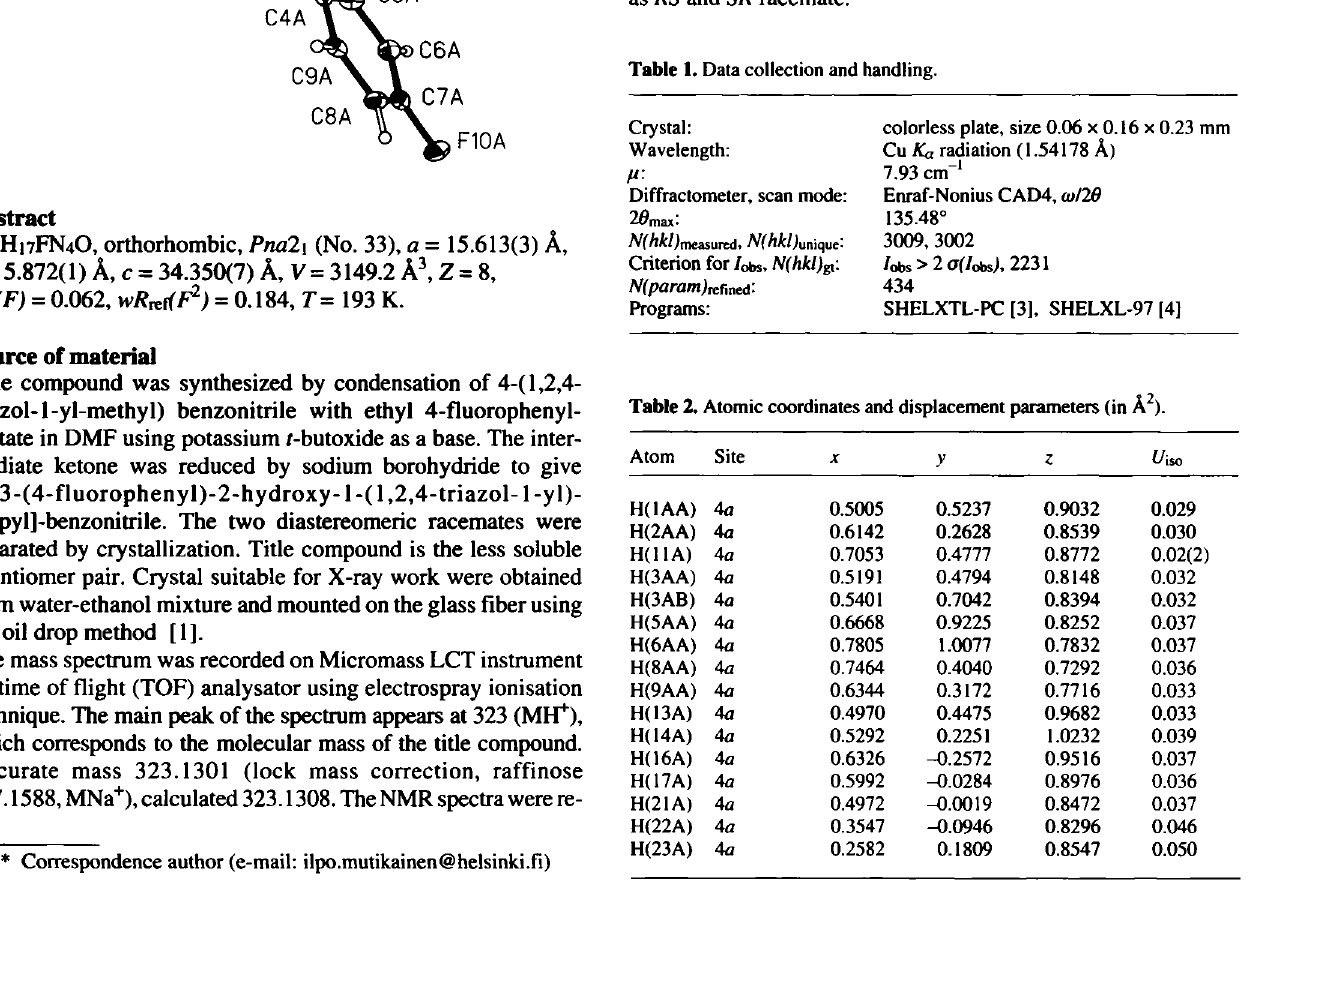
Table 1. Data collection and handling.